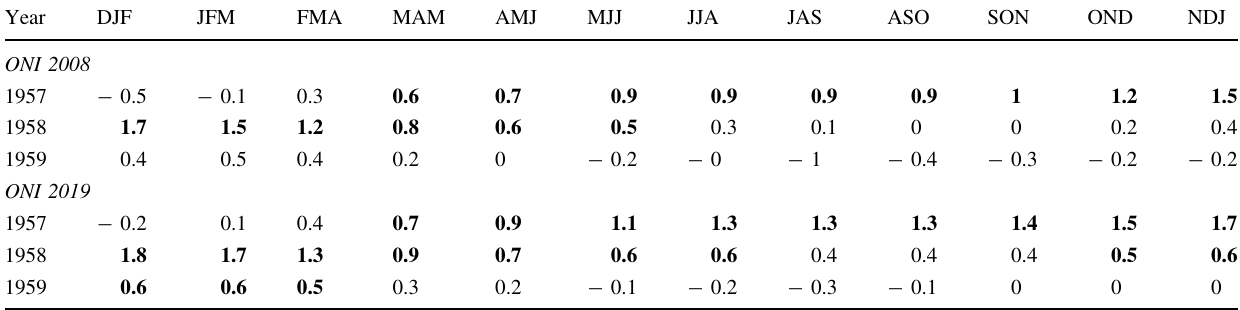
Table 6 Oceanic Nin˜o Index (ONI) data values in 2008 and 2019, comparing 1957 to 1959 (Bold numbers = El Nin˜o event). DJF December– January–February, and so forth. Source : NOAA (2010,